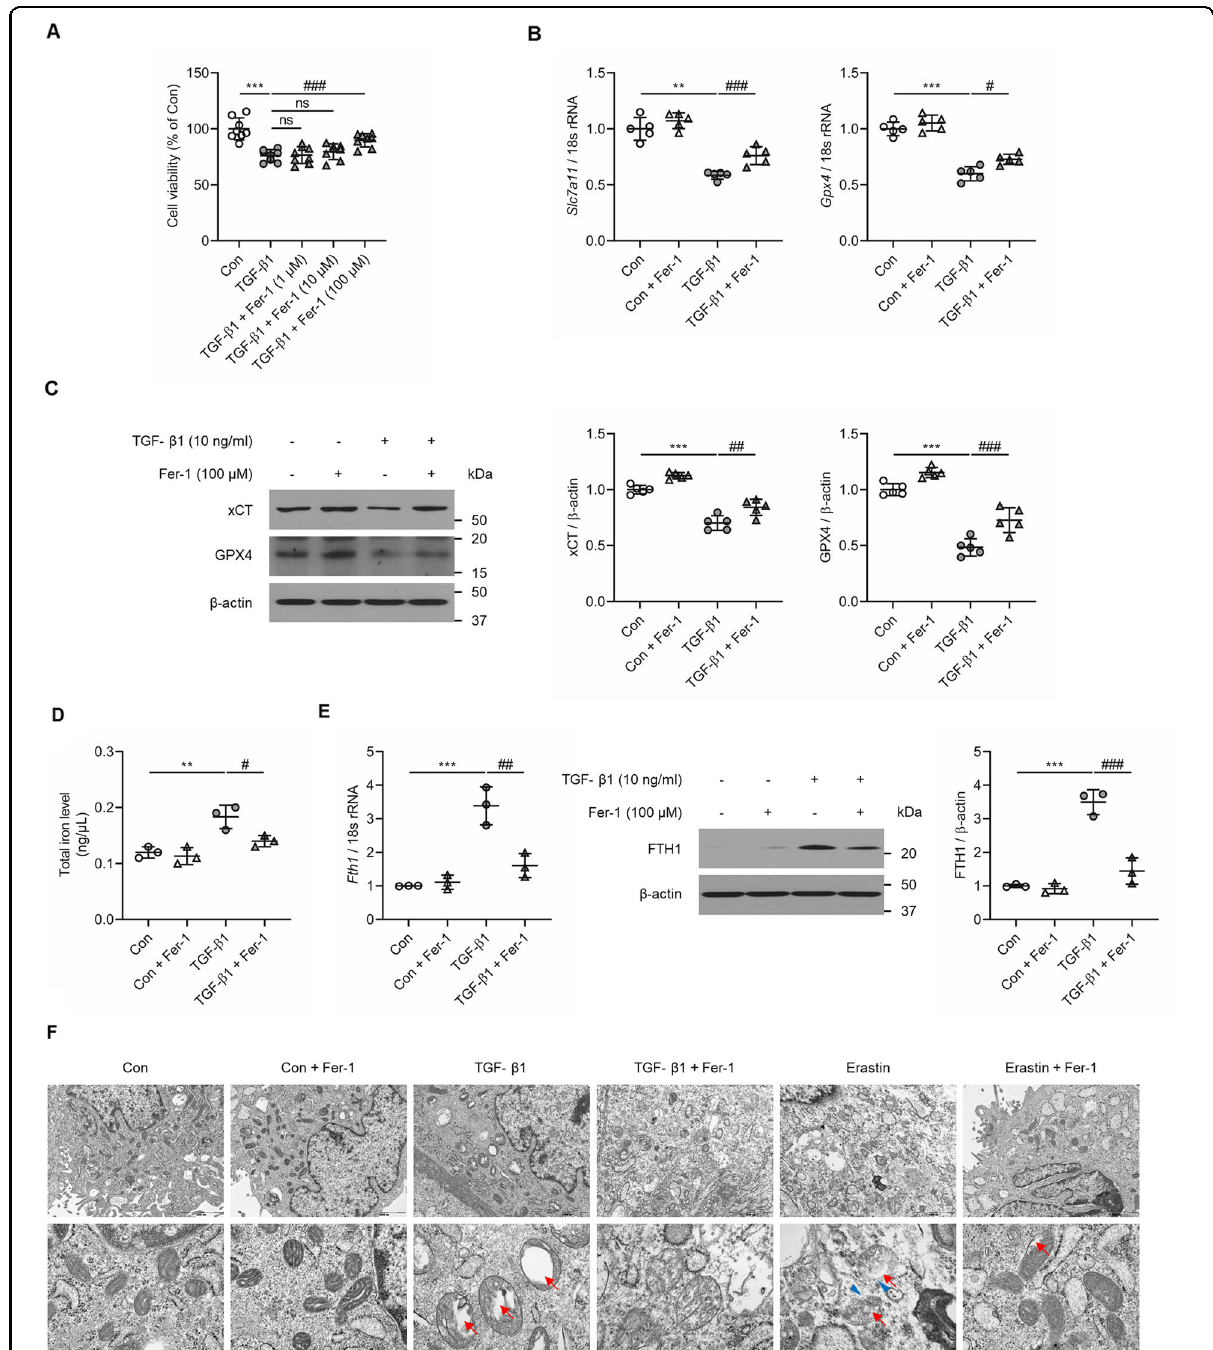
Fig. 3 Effect of Fer-1 treatment on cell viability and changes in ferroptosis-related molecules in TGF- β 1-stimulated NRK-52E cells at 12 h. A MTT assay revealed that administration of Fer-1 (100 µM) signi fi cantly abrogated the decrease in cell viability in cultured NRK-52E cells exposed to TGF- β 1 (10 ng/ml). B The decrease in Slc7a11 and Gpx4 mRNA expression seen in TGF- β 1-stimulated NRK-52E cells was signi fi cantly ameliorated after Fer-1 treatment. C The decrease in xCT and GPX4 protein expression seen in TGF- β 1-stimulated NRK-52E cells was signi fi cantly attenuated after Fer-1 treatment. D The increase in total iron levels in TGF- β 1-stimulated NRK-52E cells was signi fi cantly abrogated after Fer-1 treatment. E The increase in protein and mRNA expression levels of FTH1 in TGF- β 1-stimulated NRK-52E cells was signi fi cantly attenuated after Fer-1 treatment. F Transmission electron microscope images of mitochondria. Red arrow indicates mitochondria cristae vanish. Blue arrowhead indicates outer mitochondria membrane rupture. As shown is representative of three independent replicates. One-way ANOVA and Bonferroni post hoc tests were used for statistical analysis. Error bars represent SD. Original magni fi cation, ×150 for upper and ×600 for lower. Scale bar = 2000 µm (upper), 500 µm (lower). ** P < 0.01; *** P < 0.001 versus Con group. # P < 0.05; ## P < 0.01; ### P < 0.001 versus TGF- β 1